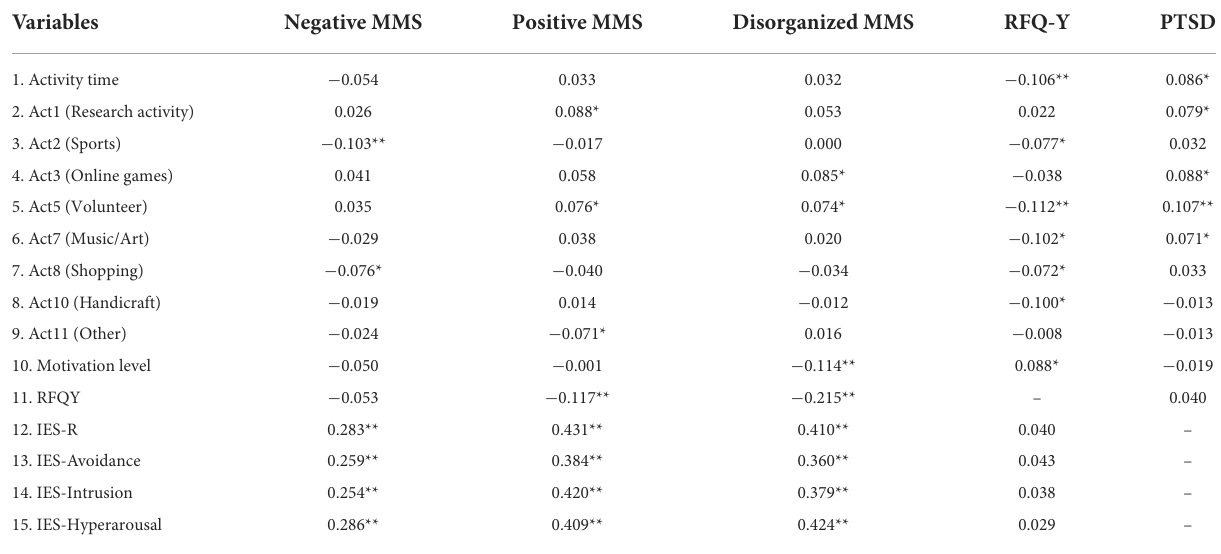
TABLE 10 Correlations